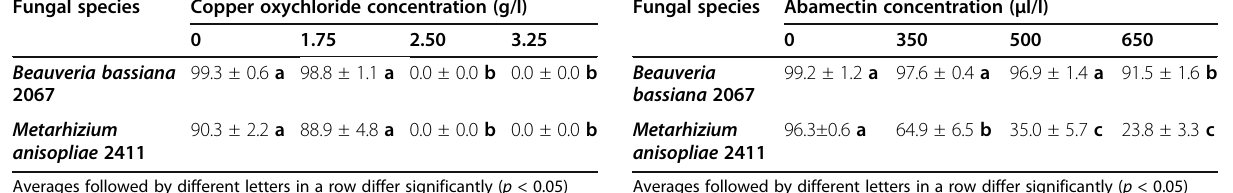
Table 5 Viability (germination percentage) of the spores according to the different treatments with abamectin Fungal species Abamectin concentration ( μ